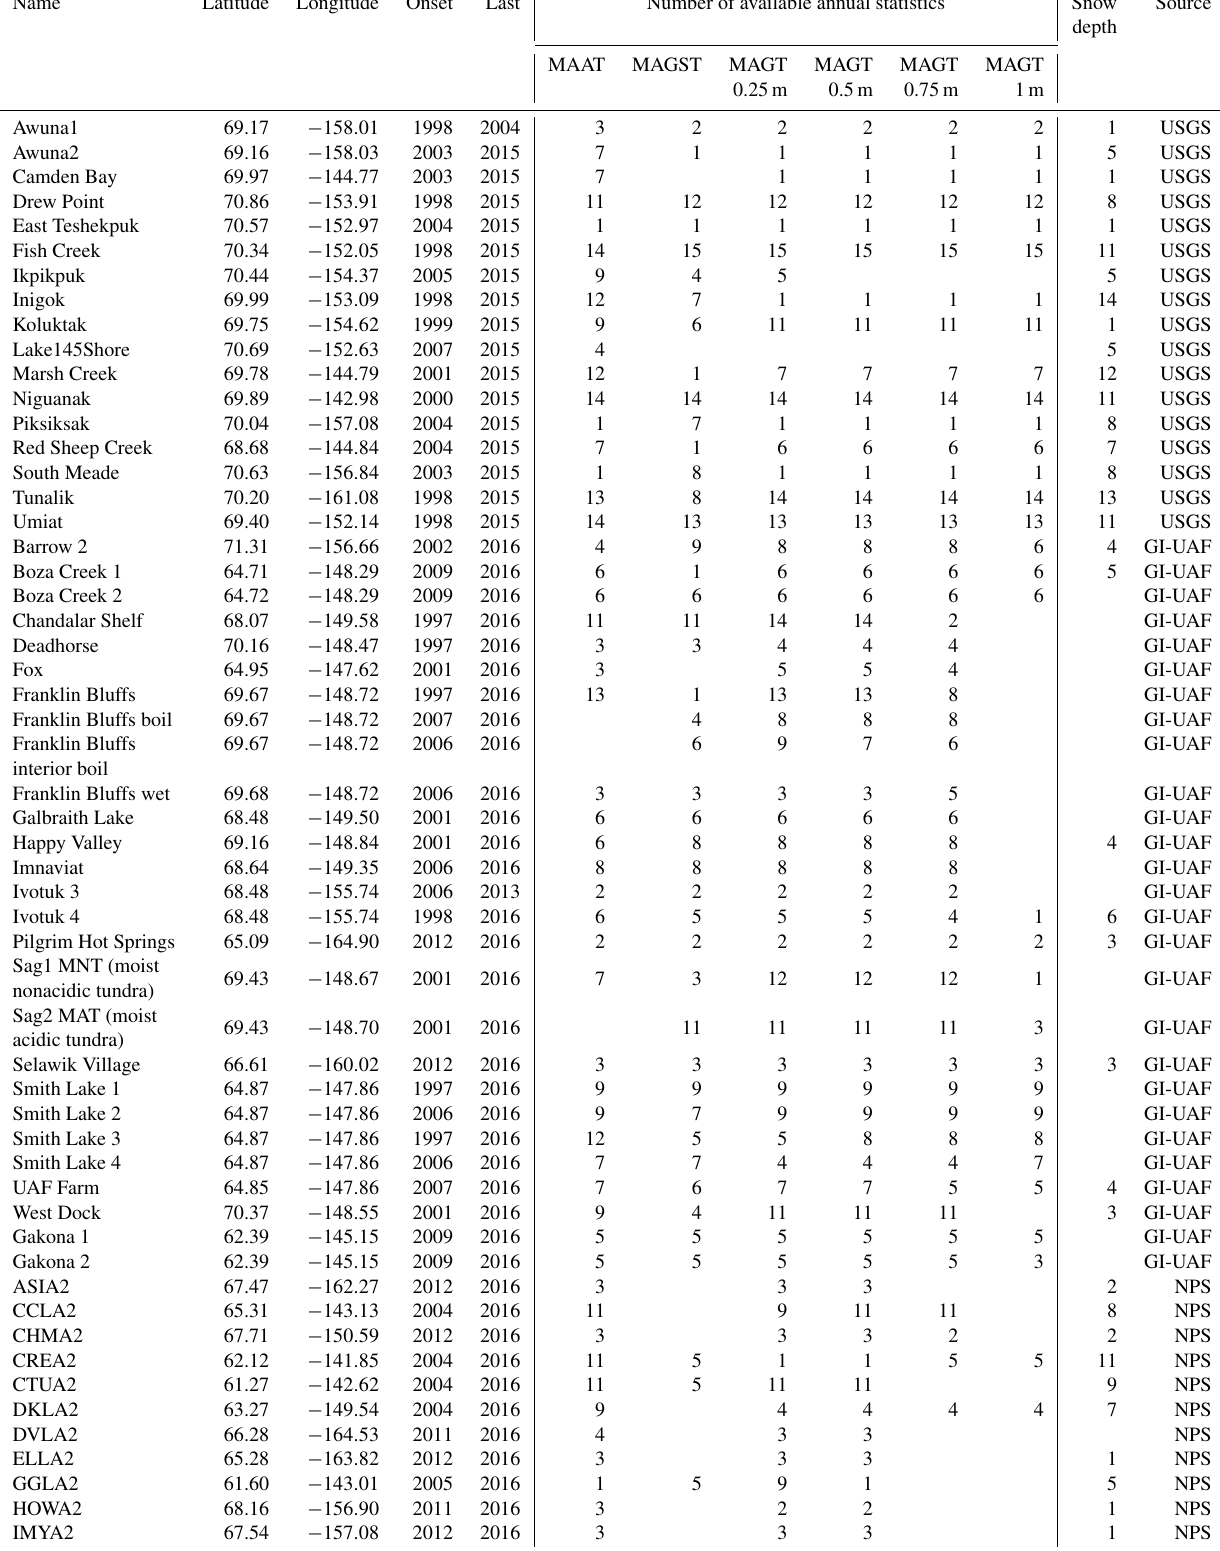
Table 1. Overview of the data from the permafrost monitoring stations in